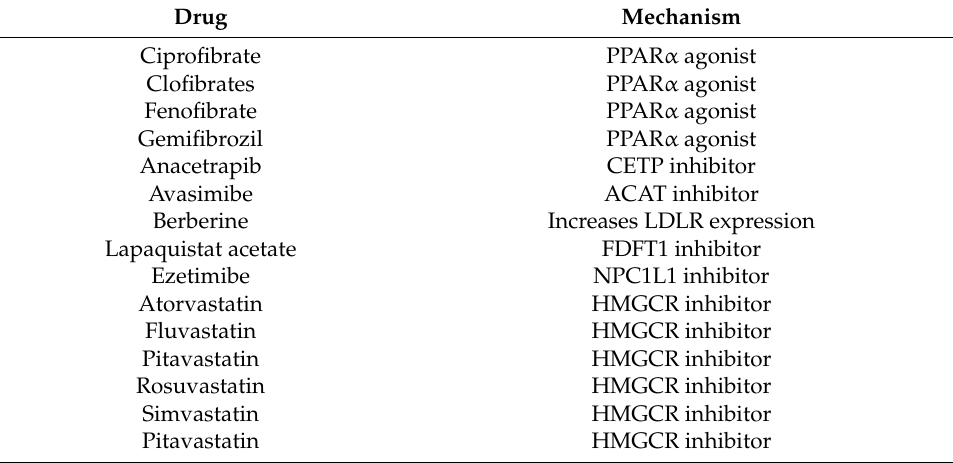
Table 1. Commercial drugs targeting cholesterol